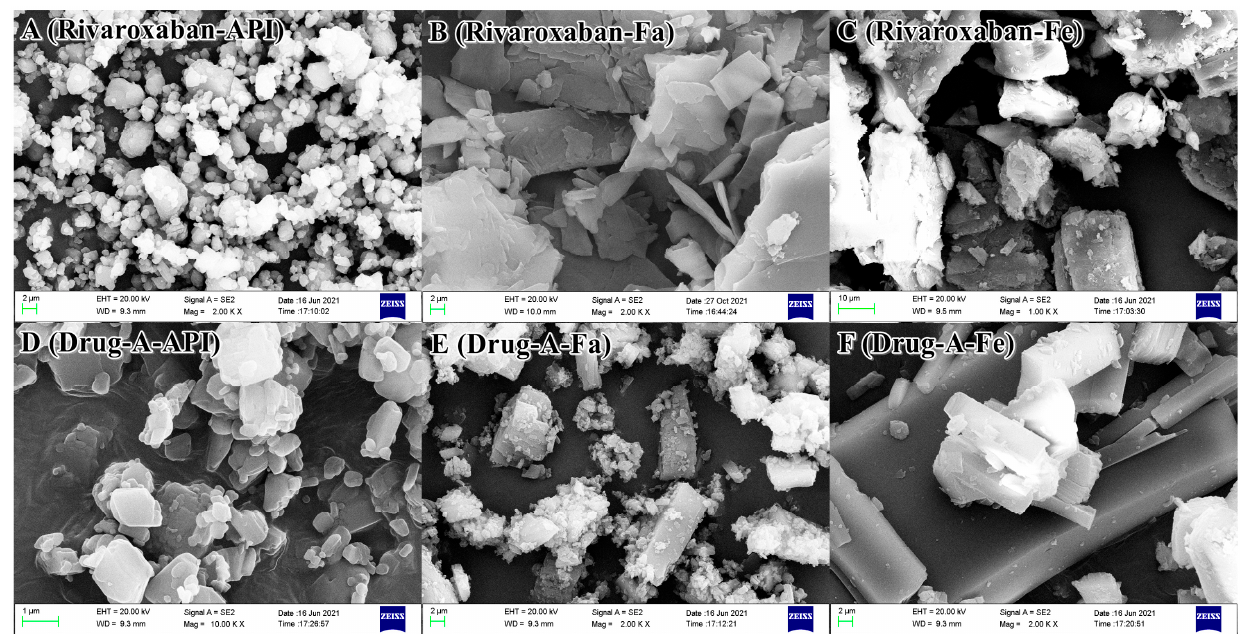
Figure 2. The microscopic morphology of API and precipitates. ( A ): API of rivaroxaban; ( B ) pre- cipitate of rivaroxaban comes from FaSSIF medium; ( C ) precipitate of rivaroxaban comes from FeSSIF medium; ( D ): API of Drug-A; ( E ) precipitate of Drug-A comes from FaSSIF medium; ( F ) precipitate of Drug-A comes from FeSSIF medium).